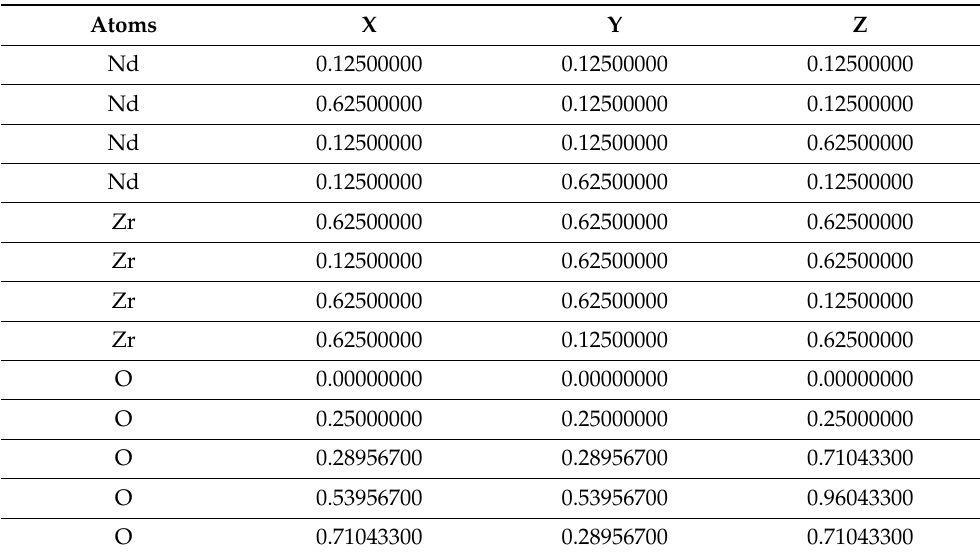
Figure 1. Crystal structures for ( a ) Fd-3m and ( b ) Pmma phases of Nd 2 Zr 2 O 7 compound. Table 1. Space group Fd-3m (227), lattice parameters, and fractional coordinates.